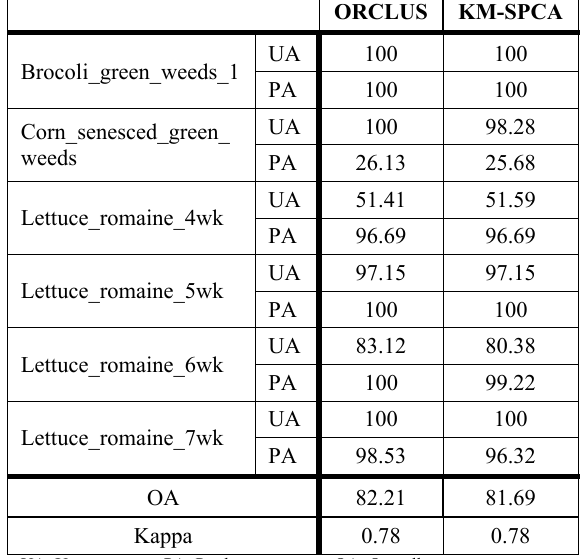
with color codes for different classes, and Classification maps obtained by (b) ORCLUS, (c) KM-SPCA. Table 2. Various accuracy indicators obtained by the two clustering methods for Salinas-A